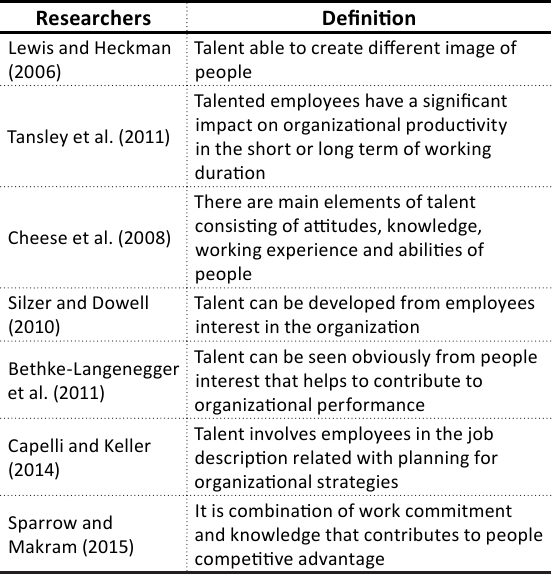
Table 1. Definition of talent